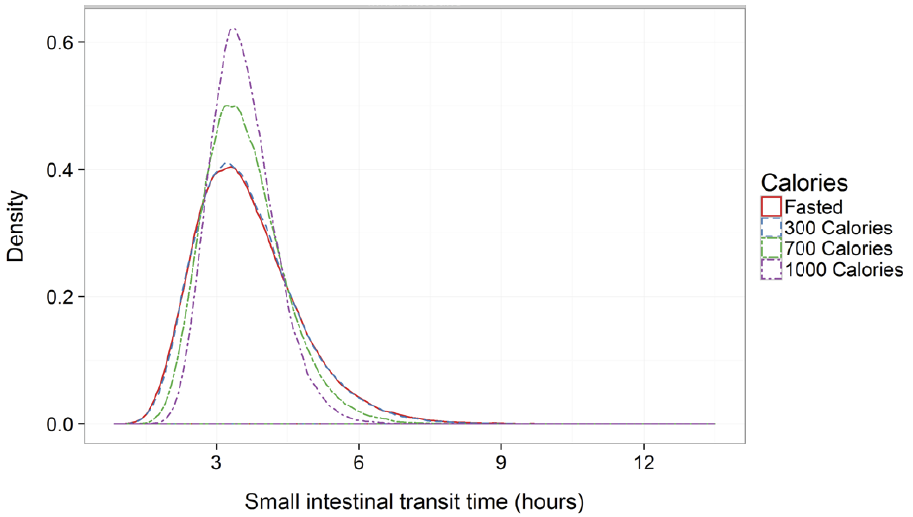
Figure 8. Meta-distribution density plot of gastrointestinal transit times in the small intestine. Reprinted with permission from Ref. [43]. 2016, Springer Nature.